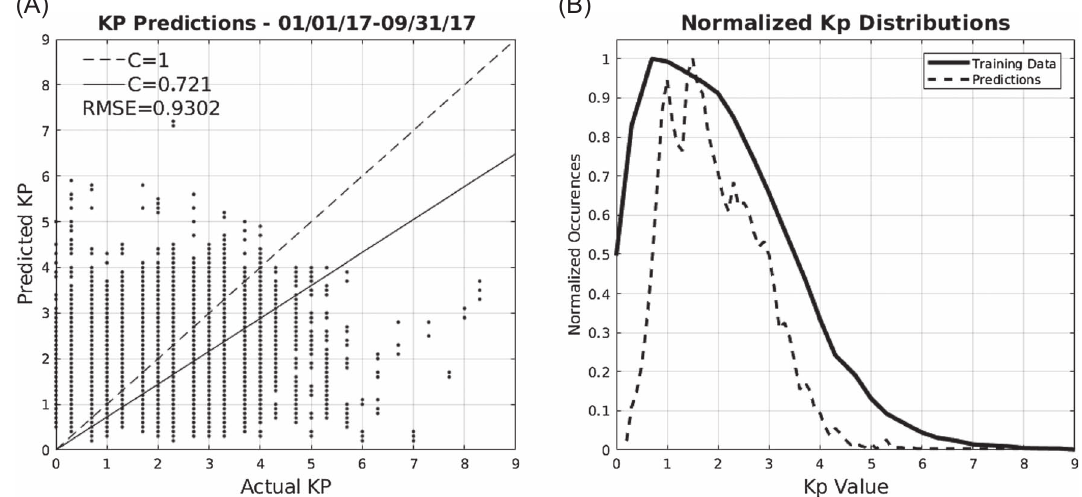
Fig. 4. (A) 6528 Kp predictions with s = 30, 01/01/2017 – 09/30/17 with inputs B z , n , r B . (B) Frequency of Kp values for full data set 1986 – 2016 and 2017 predictions. Compared with Figure 3, a smaller range of predicted Kp values is seen in both